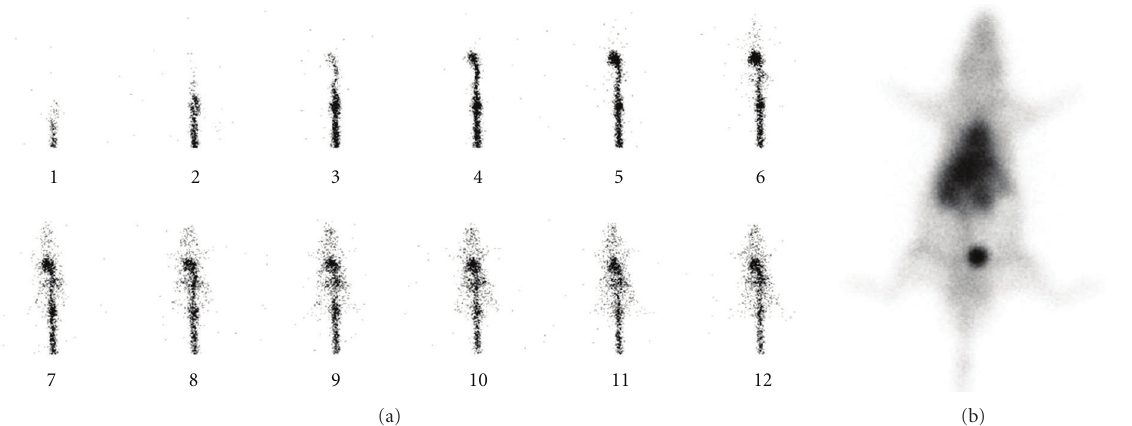
Figure 2: Image studies for the biodistribution of the 99m Tc-autoalbumin. (a) Dynamic images, rats were studied by taking 750 frames of 0.4 seconds interval; (b) static image taken at 5 min after injection with an acquisition time of 60 seconds.